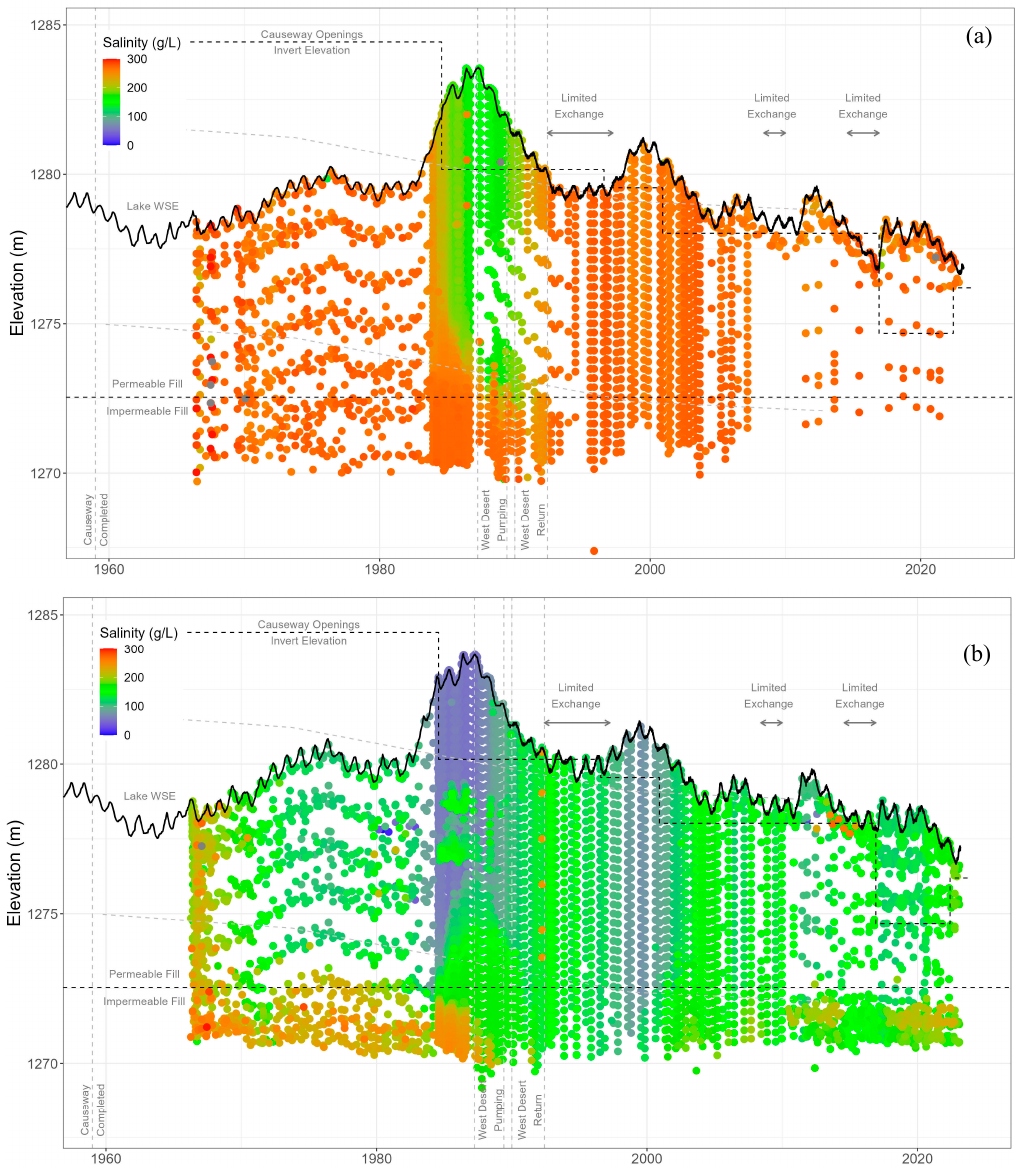
Figure 6. Salinity at depth over time in the ( a ) north arm and ( b ) south arm for all samples taken over the period of record at the UGS and USGS measurement sites shown in Figure 1. Each dot indicates a salinity calculation from a single sample site measurement. Salinity was calculated using the Naftz et al. [16] equation of state, Equation (1). Solid black line represents the WSE from USGS measurements. Horizontal dashed lines indicate causeway openings invert elevations, culvert base and top elevations, and the elevation separating permeable and impermeable fill in causeway base. Vertical dashed lines indicate date causeway was constructed and periods of west desert pumping and return.